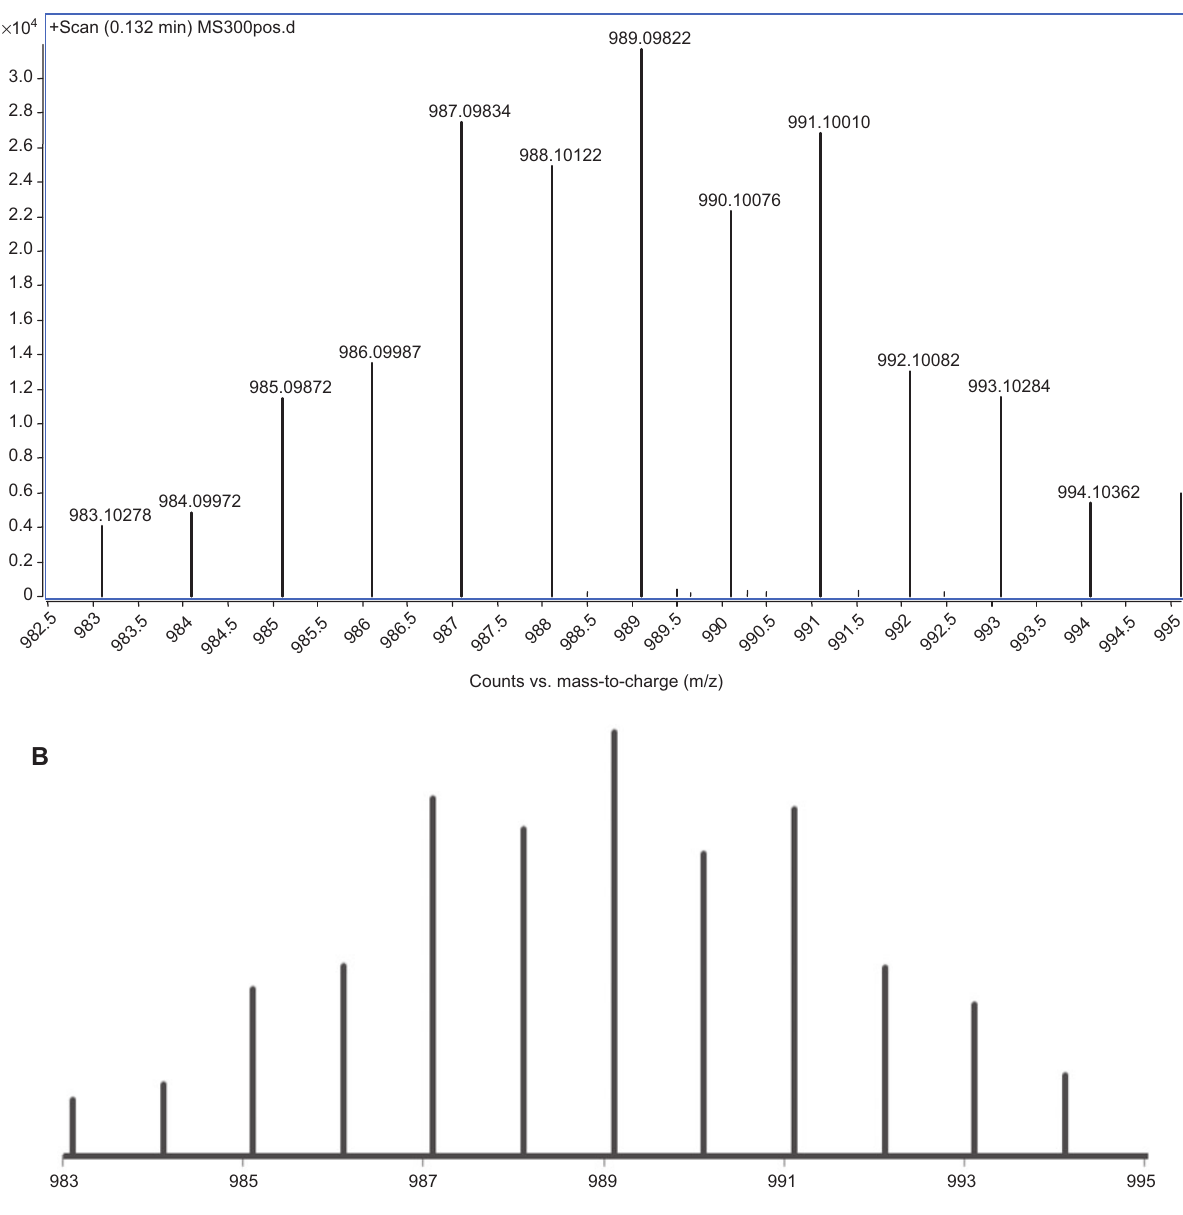
Figure 1 Experimental spectrum (A) of the mass cluster centered about m/z 989.09 found for compound ( S )-6,6 ′ -dicarboxyl- (bis(diphenylstannyl)-methane)-2,2 ′ -diethoxy-1,1 ′ -binaphthalene, 2 , [C